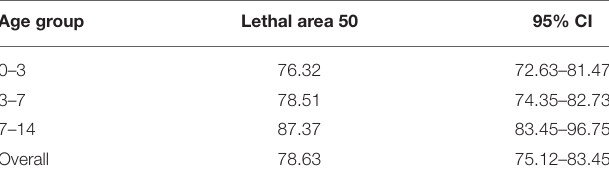
TABLE 7 | Lethal area 50 (LA50) with 95% CIs for each age